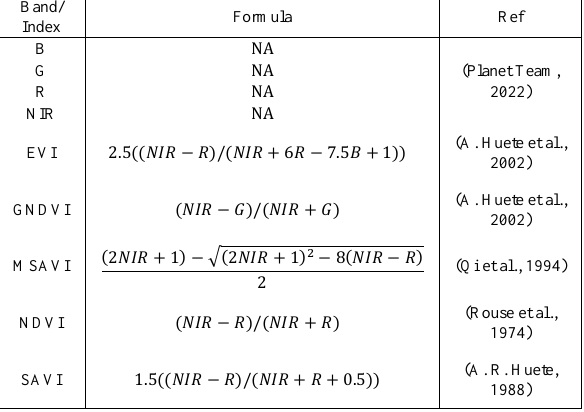
Table 1 . Summary of the spectral indices and bands used in this study for LULC